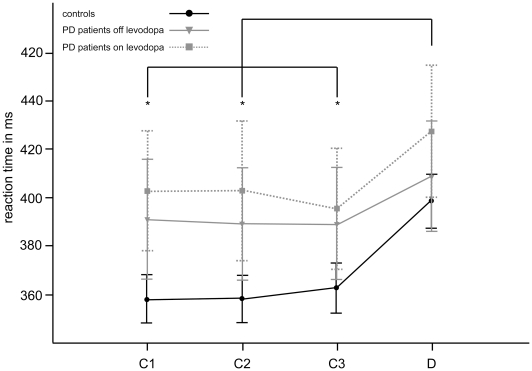
Reaction times during conditioning and deconditioning.Average reaction times are displayed per group over blocks of 40 presentations, exemplified by the responses to non-target cues in the NoGo task version with the highest number of responses (no difference was obtained between task versions). Since conditioning-deconditioning sequences comprised 120 presentations during conditioning followed by 40 presentations during deconditioning, block 1 to 3 (labelled C1, C2 and C3) reflect performance during conditioning, whereas block 4 (labelled D) equates to deconditioning. The error bars indicate the standard error of the mean. Note that reaction times increased significantly during deconditioning compared to any of the conditioning blocks (indicated by asterisks) over all groups.